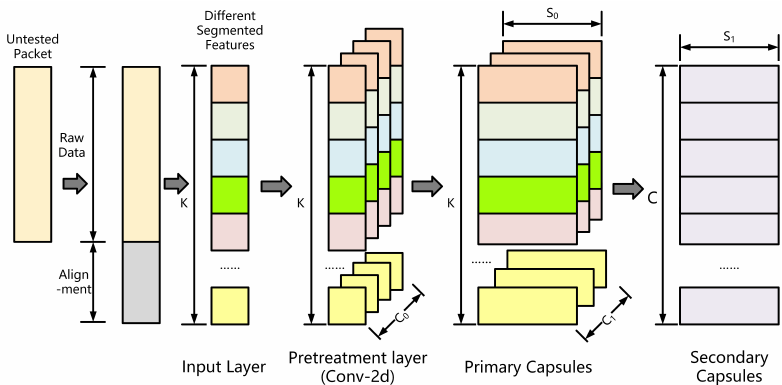
Figure 8. Segmented entropy distribution capsule neural